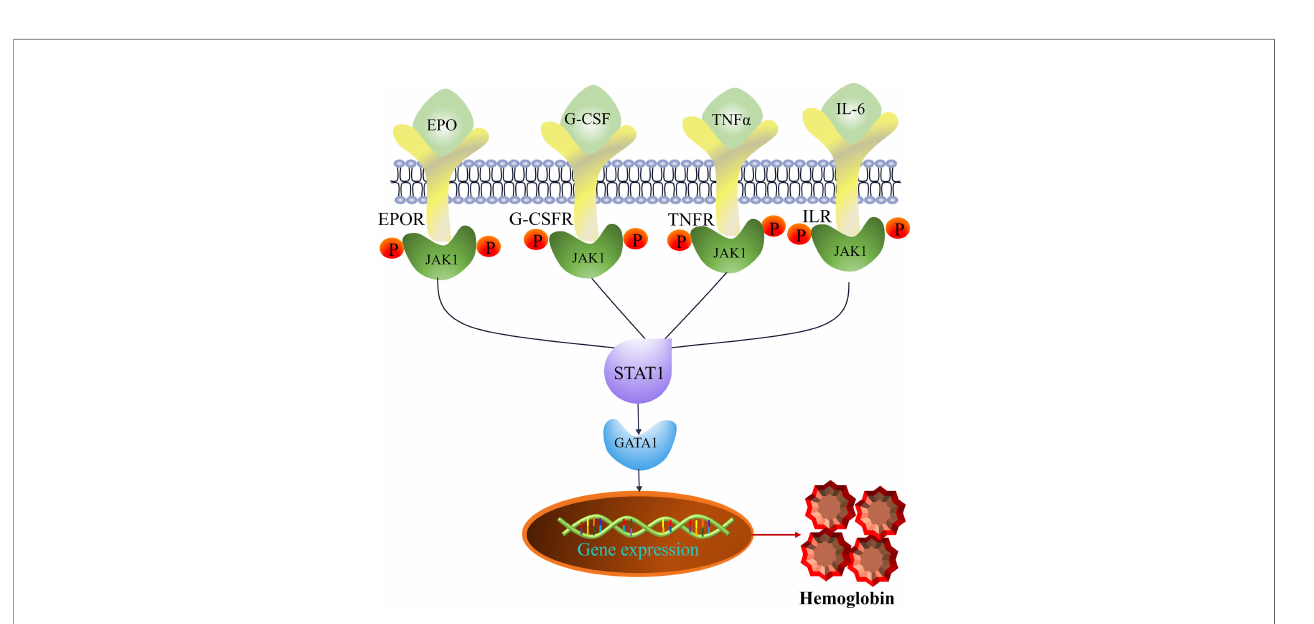
FIGURE 10 | Hematopoietic cytokines (EPO, G-CSF, TNF- a and IL-6) and targets (EPOR, JAK1, STAT1 and GATA1) predicted to be involved in the JAK-STAT